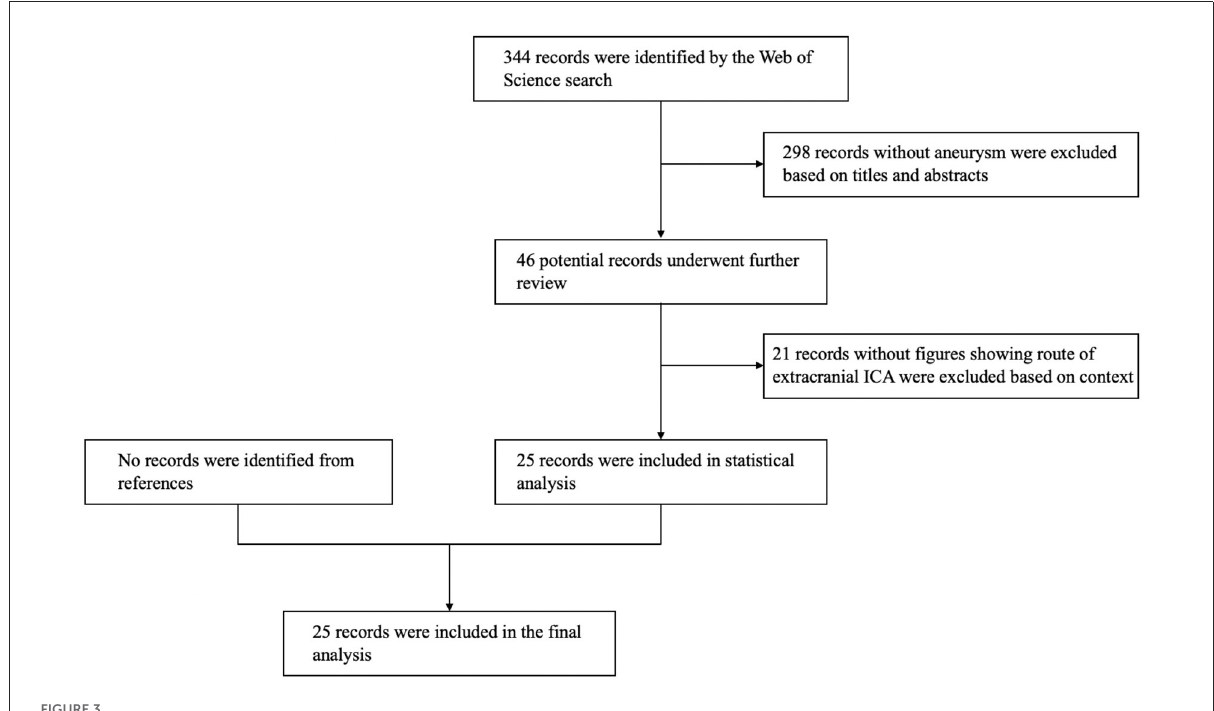
FIGURE3 Flow chart of the search